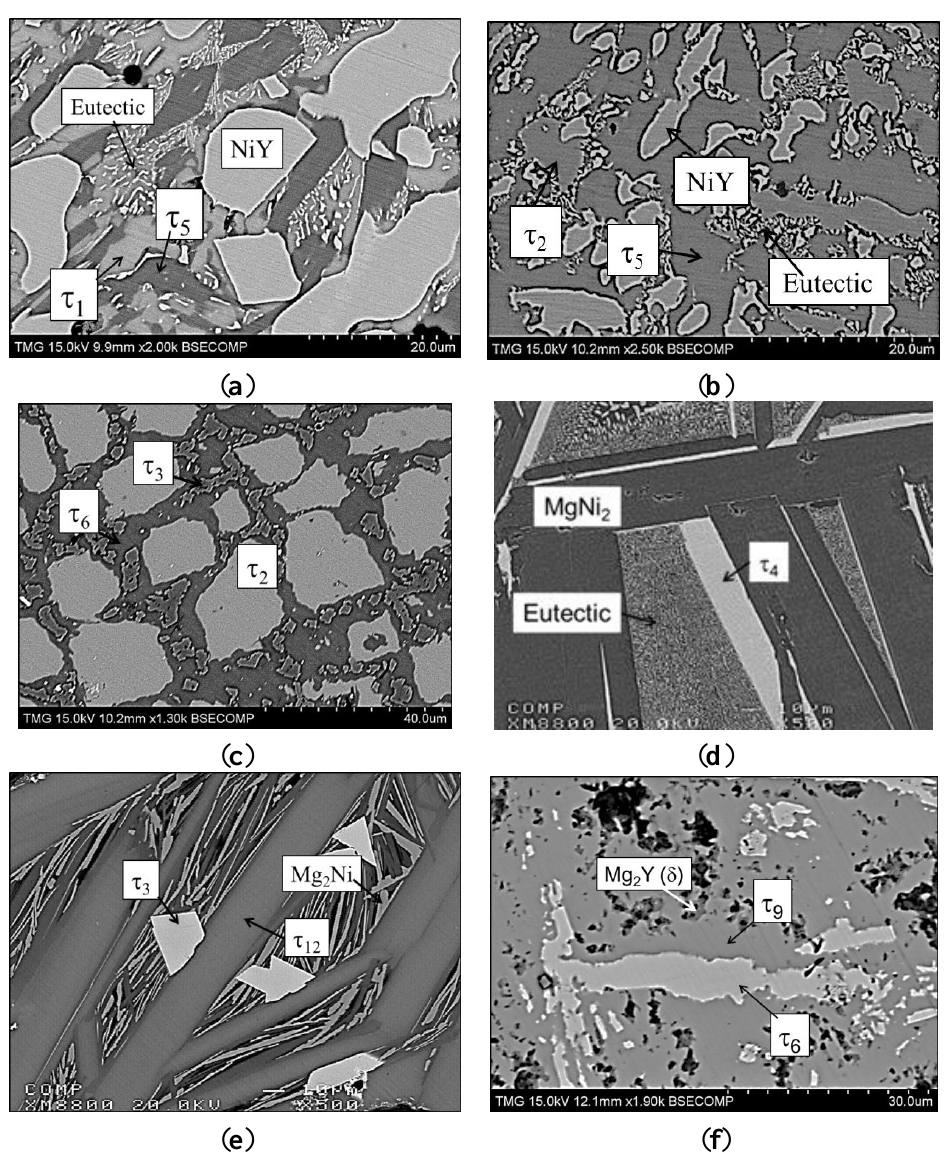
Figure 13. BSE image of ( a ) sample 1 (19.5/29.5/51.0 Mg/Ni/Y at%); ( b ) sample 9 (25.0/30.3/44.7 Mg/Ni/Y at%); ( c ) sample 11 (26.0/38.2/35.8 Mg/Ni/Y at%); ( d ) Sample 18 (28.7/69.1/2.2 Mg/Ni/Y at%); ( e ) sample 25 (78.2/15.5/6.3 Mg/Ni/Y at%); ( f ) sample 30 (54.0/15.9/30.1 Mg/Ni/Y